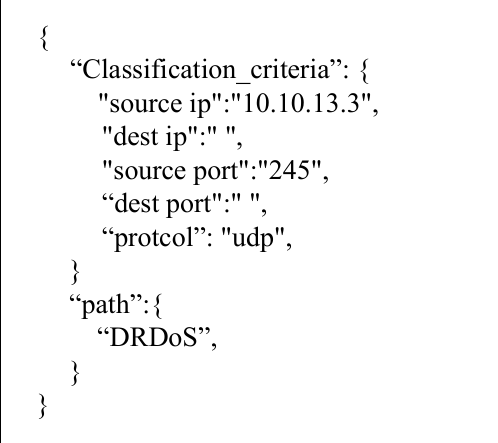
Figure 17. Dynamically adjusting the path policy.